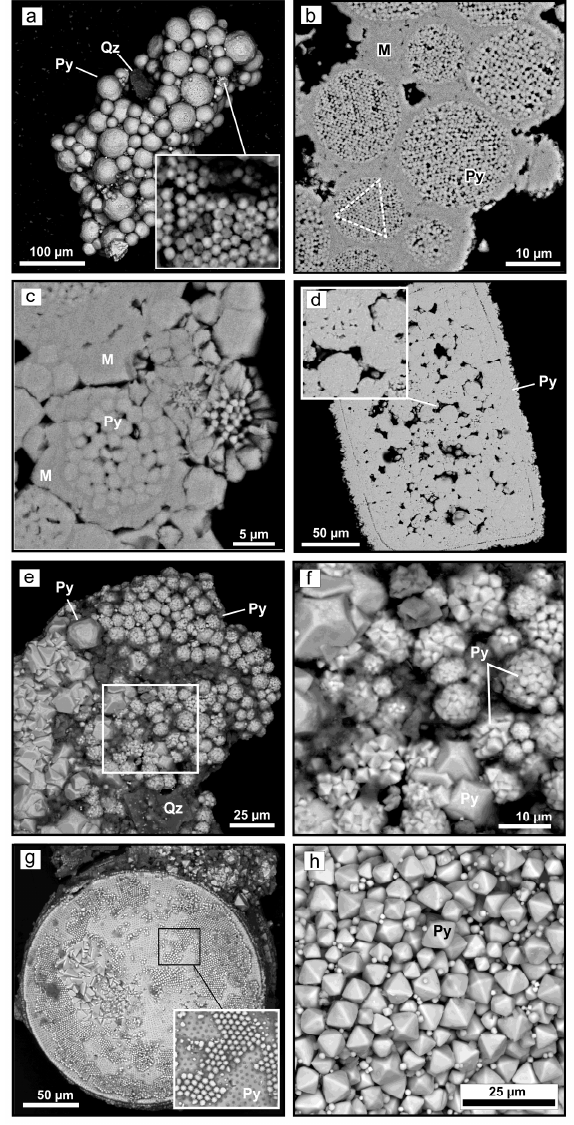
Figure 7. Morphology of primary and recrystallised pyrite framboids from mud masses (Bulganak area). ( a ) Botryoidal aggregate of primary spherical framboids and partly recrystallised framboids that acquire cubo-octahedral habits. Most framboids are ordered (sometimes with shared microcryst orientation) and filled. Crystallites comprising framboids are mostly cubo-octahedral ( b ) Botryoidal aggregate of primary spherical framboids buried in matrix. Most framboids are ordered and filled. One framboid has trigonal symmetry. Framboid crystallites are octahedral and cubo-octahedral; ( c ) Sunflower structures with framboidal core rimmed by radiating outer crystals (on the right) and partly recrystallised framboids buried in matrix; ( d ) Recrystallised framboids composing a pseudomorph after a fossil remnant. Framboids that preserve discrete crystallites separated by holes in the core and rimmed by massive aggregates of agglomerated crystallites correspond to early recrystallisation. Completely filled spherules correspond to a more progressive stage of recrystallisation; ( e , f ) Intergrowth of primary spherical framboids (on the right) and cubo-octahedral pyrite crystals formed during recrystallisation of framboids (on the left). Framboids consist of octahedral and cubo-octahedral crystallites ( f ); ( g , h ) Aggregate of octahedral and cubo-octahedral crystals that formed during final stage of framboids recrystallisation. Crystals compose a pseudomorph after a fossil remnant and are buried in the matrix ( g ). BSE images. M = matrix; Py = pyrite; Qz = quartz. ( a , c , d ) = Tischenko Hill; ( b , g ) = Andrusov Hill; ( e , f , h ) = Trubetskoy Hill.